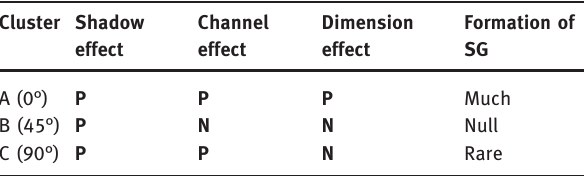
Figure 10. The temperature gradient (G) was calculated from the simulation results, and the solidification rate (V) was usually assumed to be approximately equal to the withdrawal rate. In previous researches, the areas in process window were usually divided by analytical method or fitted by the points of experimental results